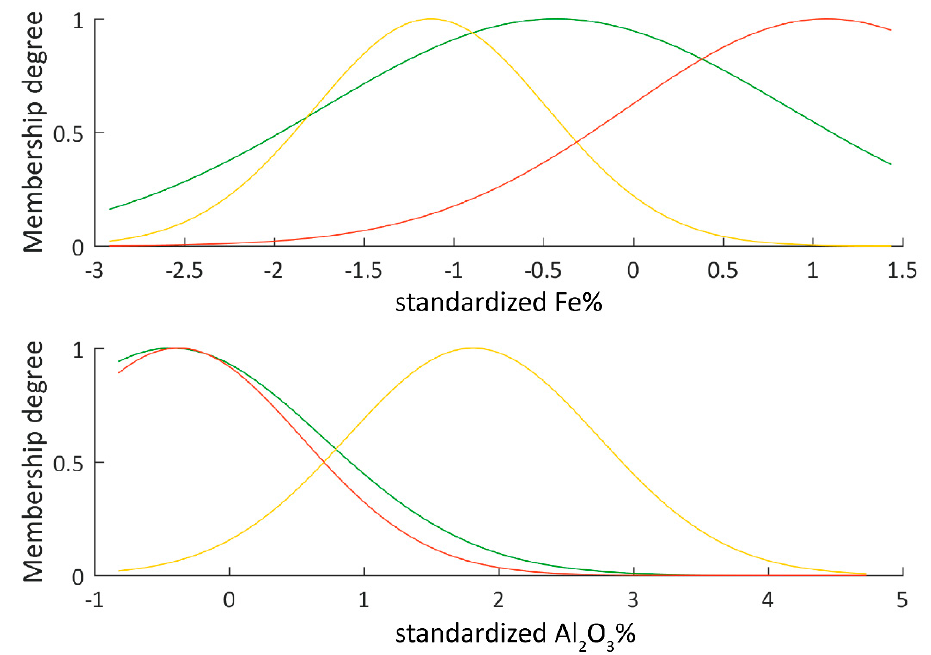
Figure 5. Membership functions for the two input variables before training of the fuzzy inference system. The yellow functions define membership to cluster 1 (SHALE), the green to cluster 2 (BIF), the red to cluster 3 (ORE).